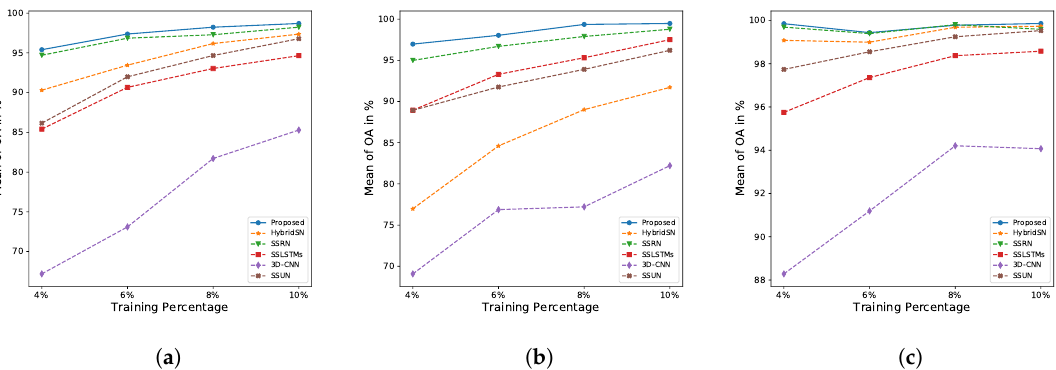
Figure 9. Overall accuracy of each method for different training data sizes of: ( a ) Indian Pine dataset, ( b ) KSC dataset, and ( c ) Pavia University dataset.